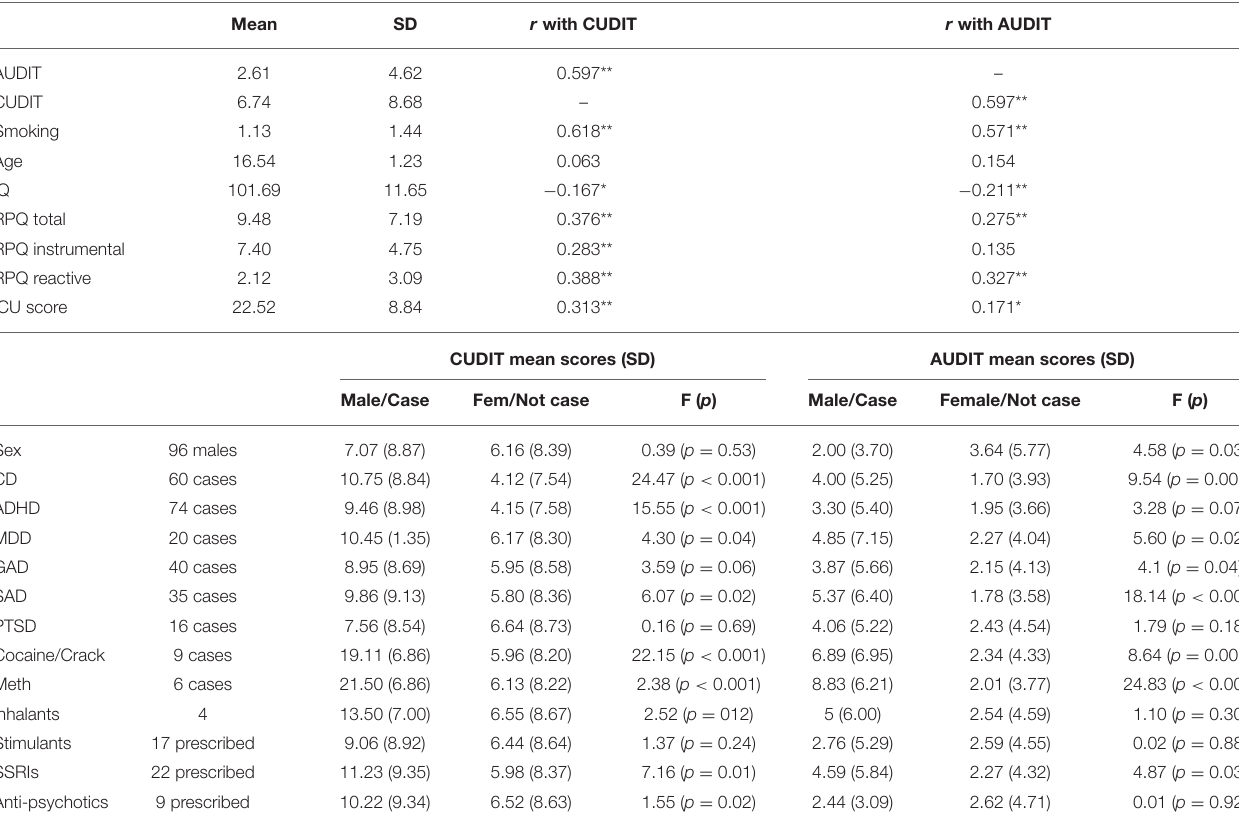
TABLE 1 | Demographic and clinical variables.